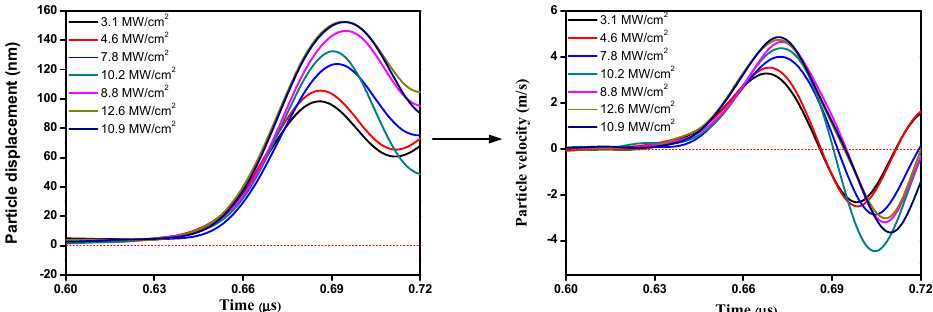
Figure 4. The transformation of profiles of the particle displacement ( left ) and of the particle velocity ( right ) in longitudinal acoustic pulses arriving to the rear (detection) surface of the plate directly from the front (generation) surface of the plate with increasing laser power densities applied for the excitation of the LSCP layer.